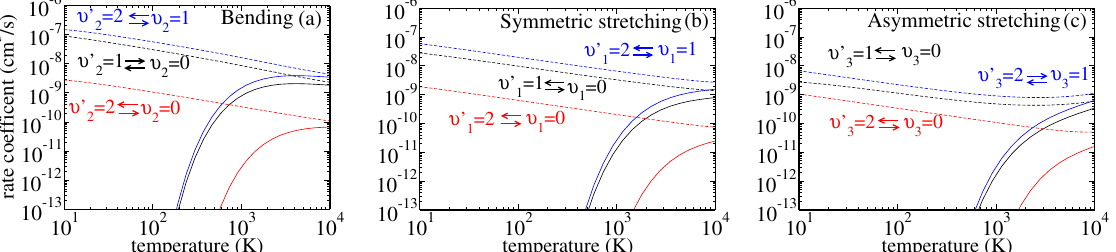
Figure 6. Same as Figure 3 for the calculated rate coefficients. Dashed lines represent de-excitation transitions, while the solid lines of the same colour refer to opposite